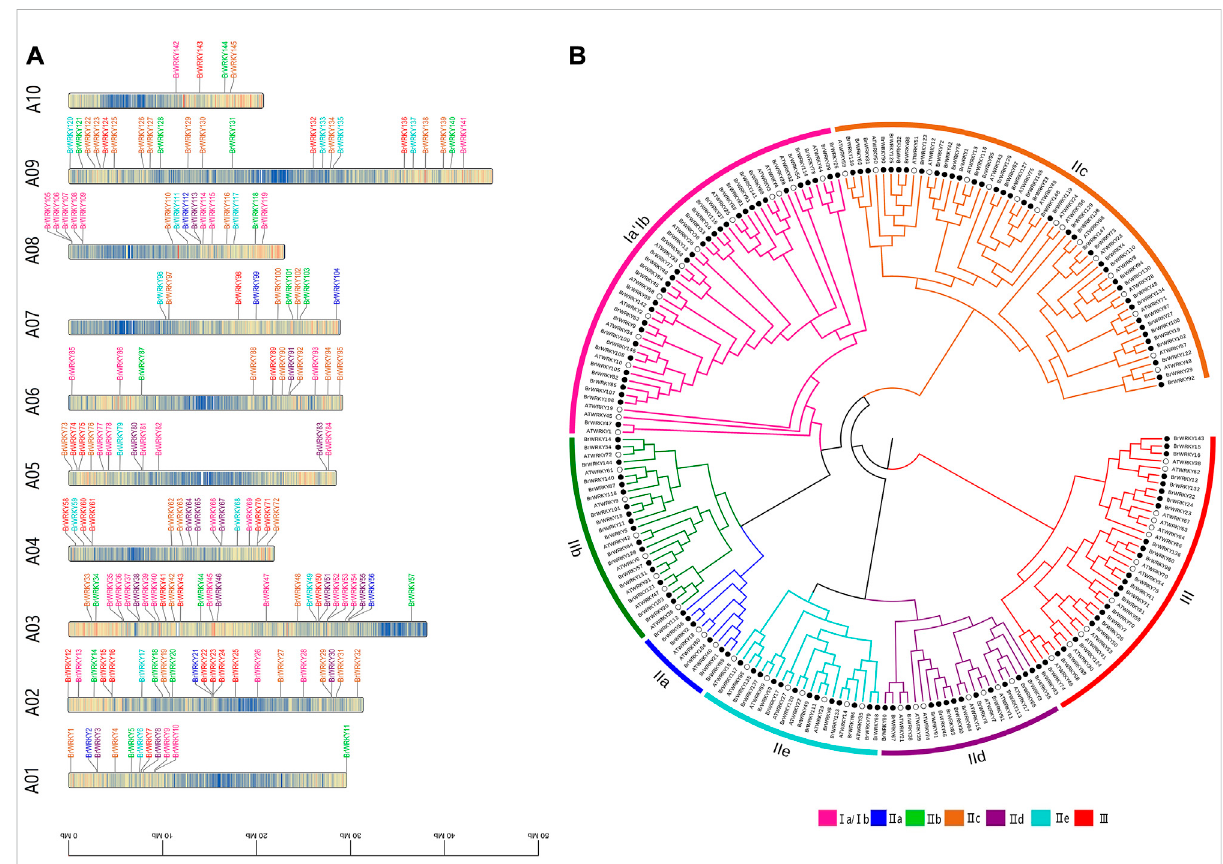
FIGURE 1 Chromosomal location and phylogenetic tree analysis of BrWRKY family members. (A) Classi fi cation and distribution of the 145 BrWRKY genes in Chinese cabbage identi fi ed in this study on 10 chromosomes and visualized by TBtools (another three located in subgenomes are not shown). (B) Multiplealignmentofthe148BrWRKYsand71AtWRKYsfrom Arabidopsisthaliana ,andthephylogenetictreewasconstructedbyMEGAbasedonthe neighbor-joining (NJ)